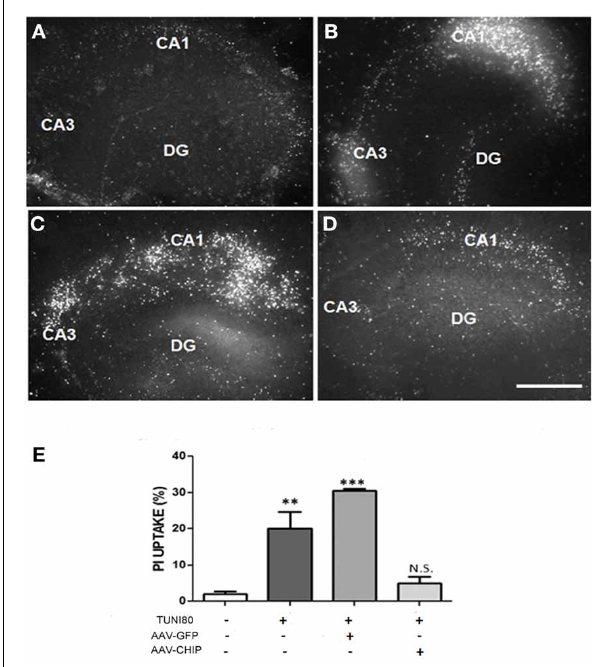
FIGURE 4 | Overexpression of CHIP attenuates PI uptake in all hippocampal subregions induced by Tunicamycin. Hippocampal slices were infected with rAAV8-GFP or rAAV8-CHIP. After 13 days in vitro , the slices were incubated with Tunicamycin at 80 μ g/mL for 24h. Freshly slices were incubated with PI. PI uptake of vehicle treated slice (A) , Tunicamycin at 80 μ g/mL (B) , rAAV8-GFP + Tunicamycin at 80 μ g/mL (C) , rAAV8-CHIP + tunicamycin at 80 μ g/mL (D) . 4x Magnification, scale bar: 500 μ m. (E) Quantification of PI fluorescence percentage relative to maximum fluorescence values ∗∗ p < 0 . 05; ∗∗∗ p < 0 . 0001. Values represent ± S.E.M. comparing all groups to vehicles. Confidence Interval: 99%; p < 0 . 01; N = 4 independent